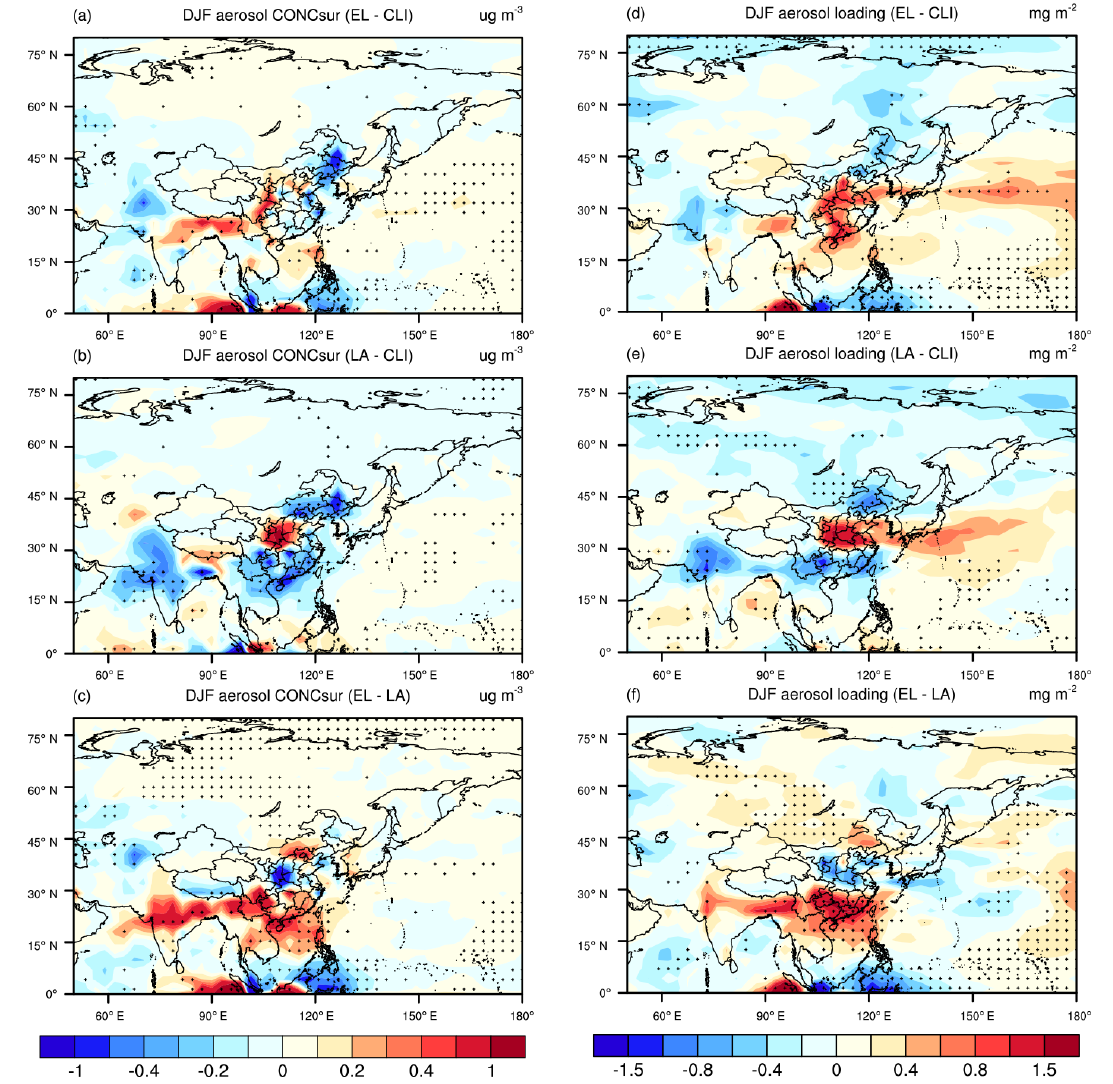
Figure 9. Medians of the simulated differences in winter-average aerosol surface concentrations (left panel; units: µgm − 3 ) and aerosol loadings (right panel; units: mgm − 2 ) between EL and CLI (a, d) , LA and CLI (b, e) , and EL and LA (c, f) , with black dots indicating that the differences between more than 70% of ensemble member pairs have the same sign as the median